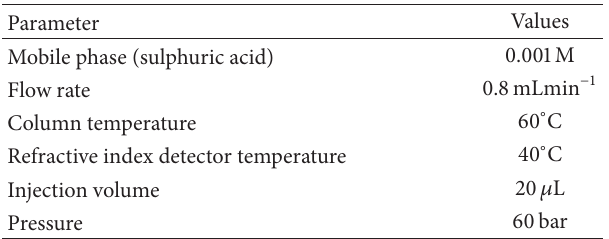
Figure 2: ((a)-(b)) Pictures showing a single cashew apple and a mixed variety of cashew apples from the Coastal Cashew plantation in KwaNgwanase, South Africa.